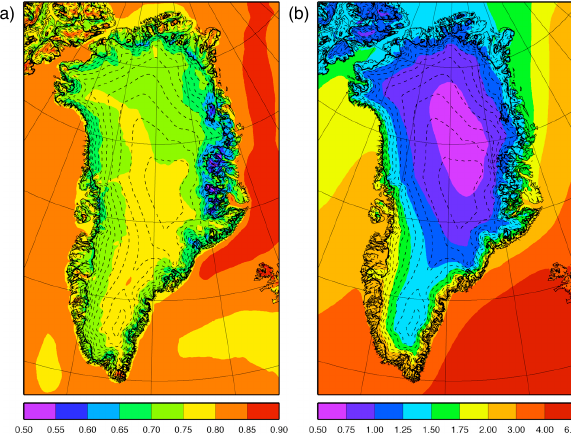
Fig. 7. Annual mean 2m (a) relative humidity [ − ], and (b) specific humidity [gkg − 1